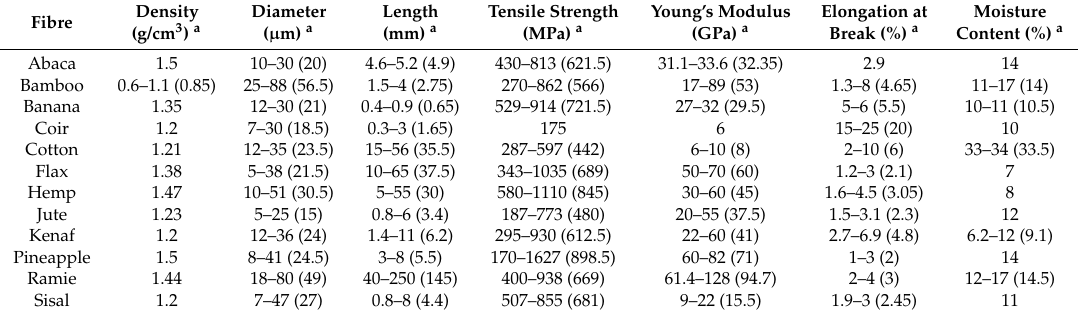
Table 5. Properties of some natural fibres Adapted from: [79,80]. a average value between parenthesis.